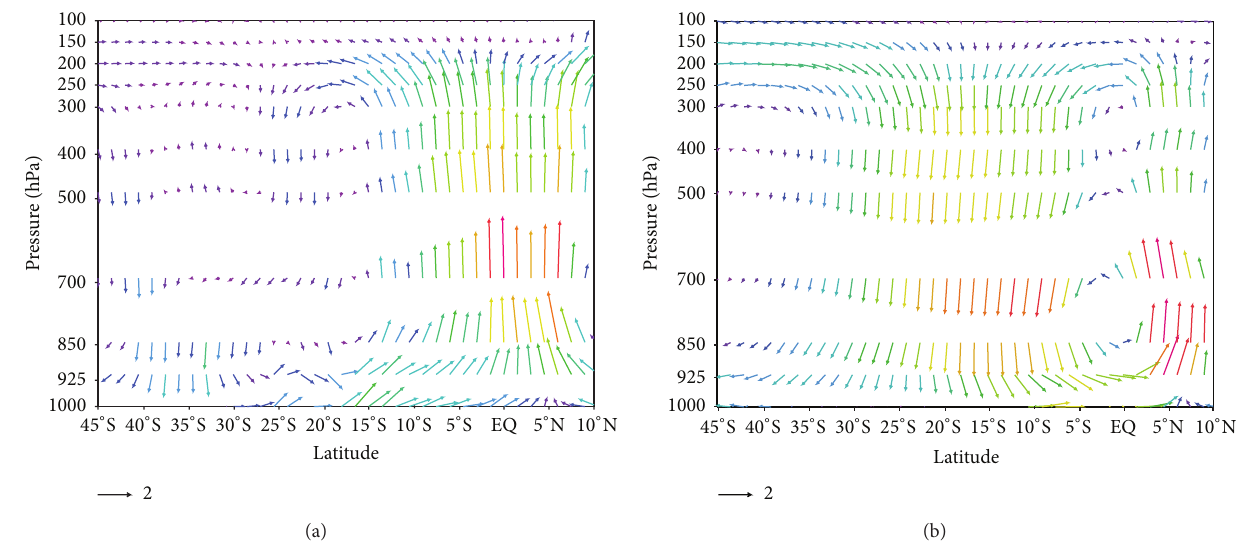
Figure 1: Annual mean of the regional HC in the period 1996–2011 over (a) South America averaged between 80 ∘ W and 45 ∘ W (HCSA) and (b) Atlantic Ocean averaged between 38 ∘ W and 10 ∘ E (HCAO). Vertical circulations are described by the vertical velocities (Pa s −1 ) and the divergent meridional winds (ms −1 ) based on the Era-Interim reanalysis. The vertical velocity has been multiplied by − 100. The color scale represents the vector’s magnitude.